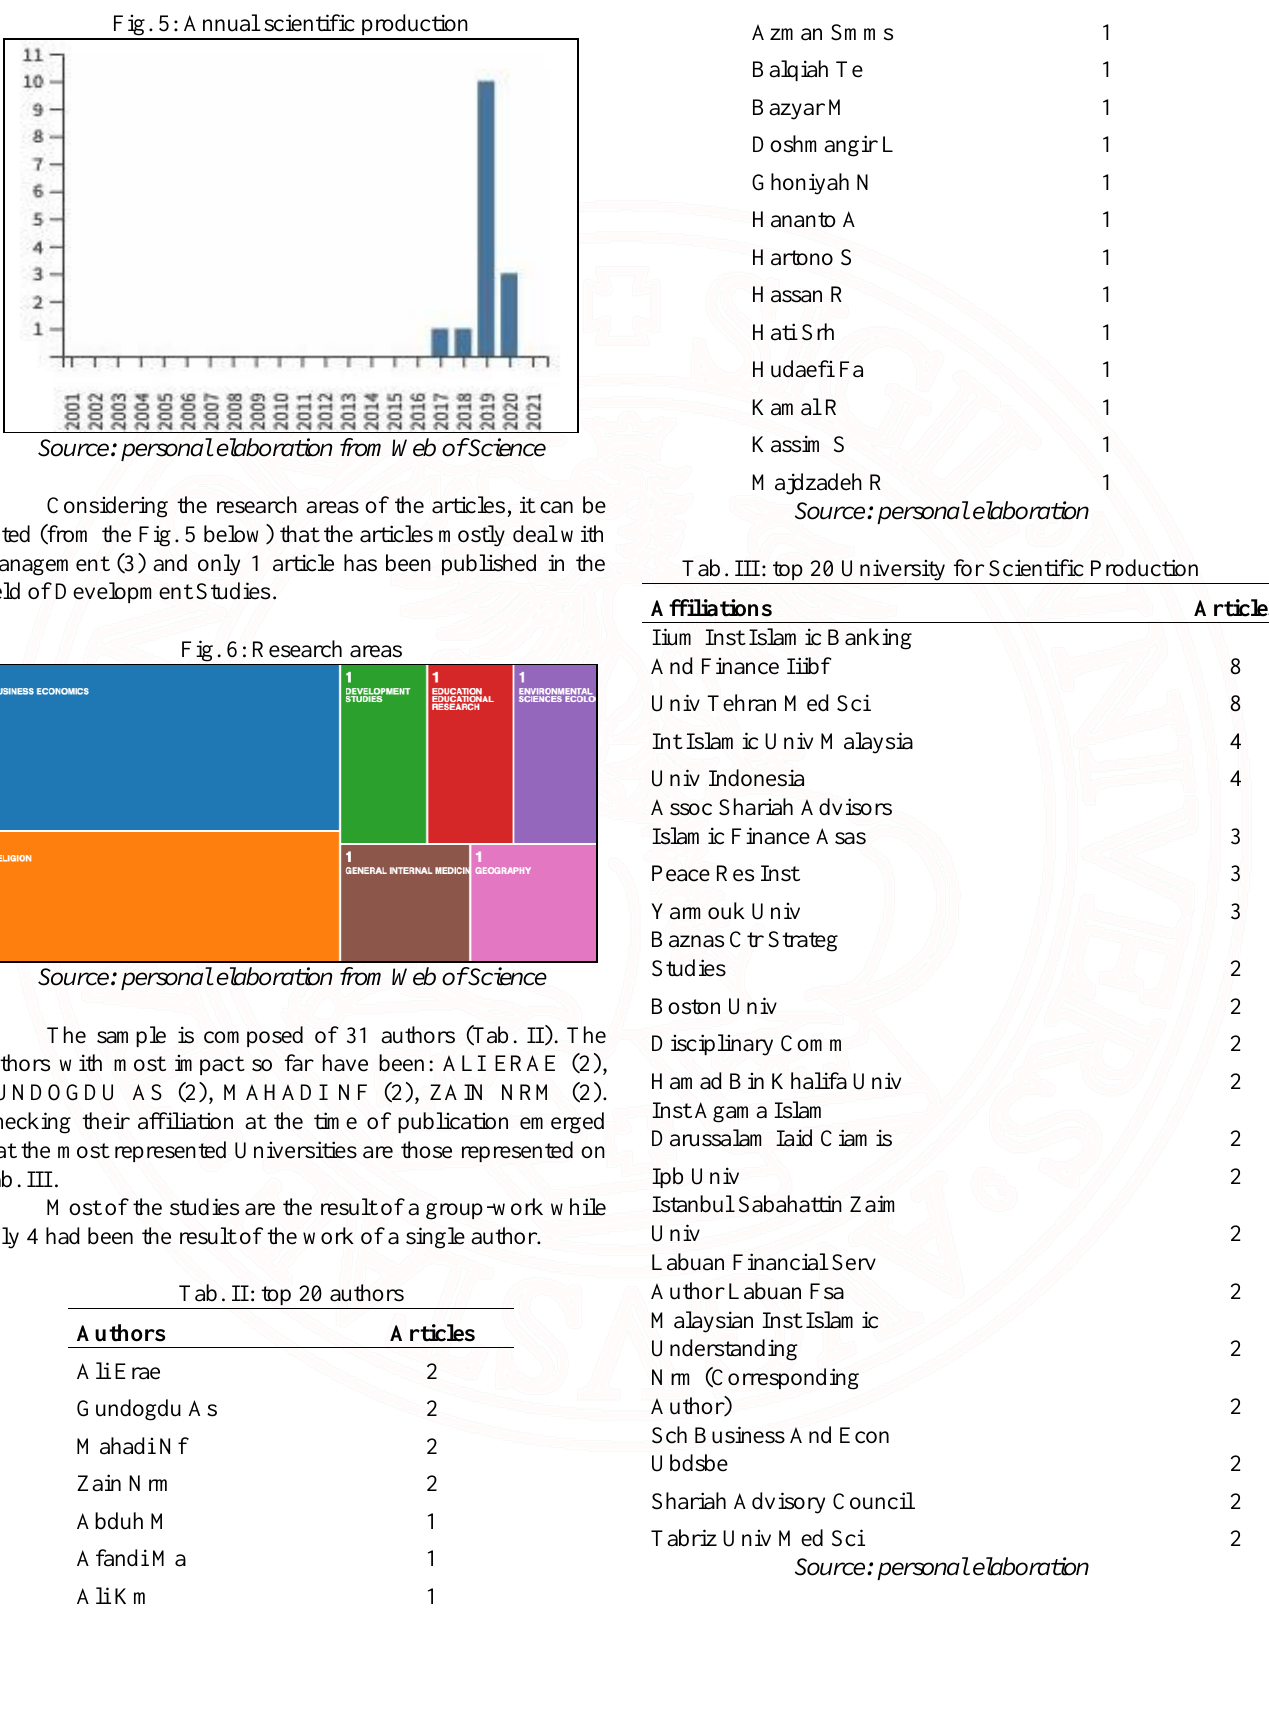
Fig. 5: Annual scientific production